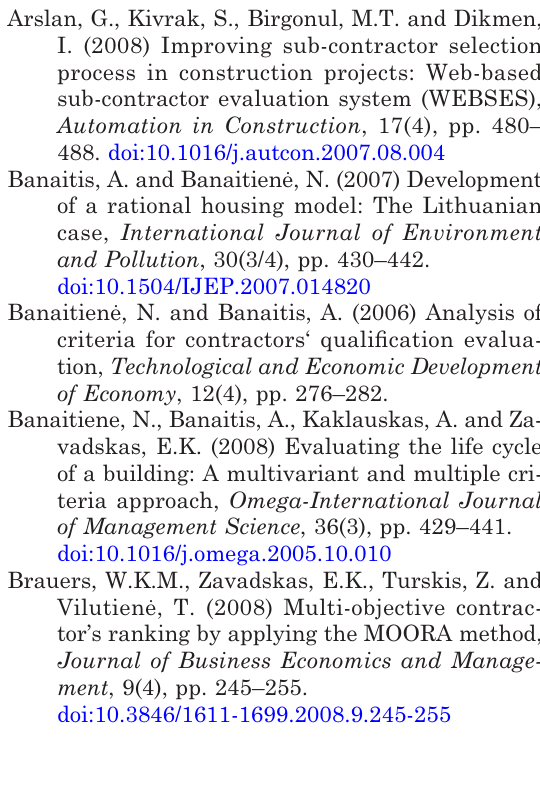
Figure 1. Comparison of initial and contractual cost calculated from the client’s viewpoint